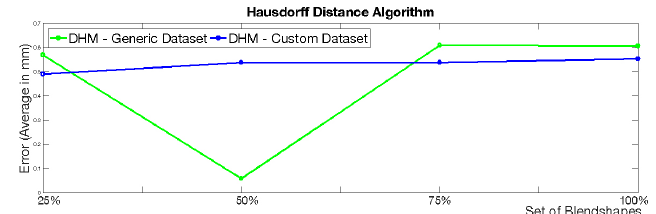
Fig. 18. Graph showing the error difference between the generic dataset and customized dataset processing for the Hausdorff Distance algorithm.